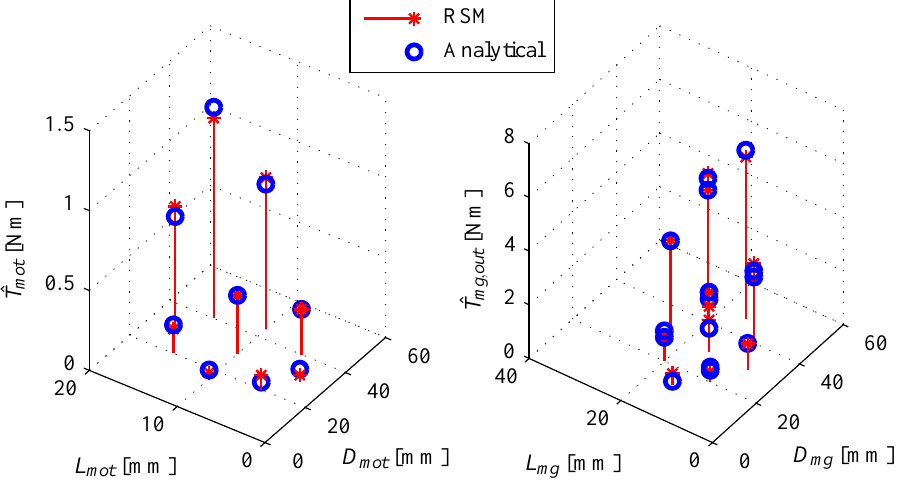
Figure 19. RSM approximated motor and magnetic gear